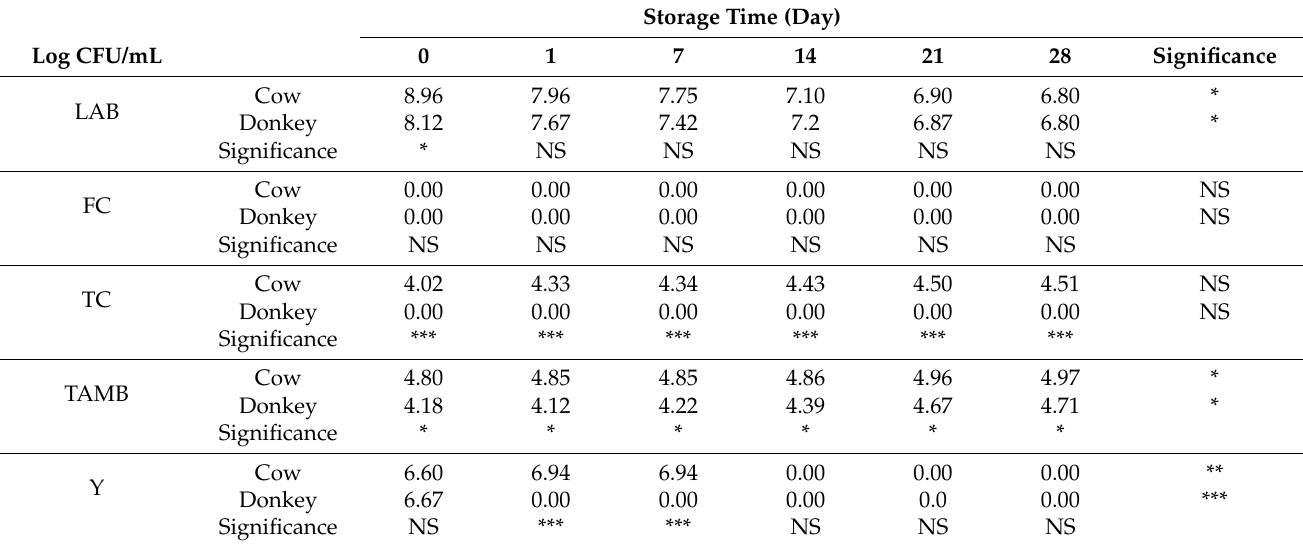
Table 2. Viable counts of total aerobic mesophilic bacteria (TAMB), lactic bacteria (LAB), total coliforms (TC), and yeasts (Y) of cow and donkey kefirs during storage at 4 ◦